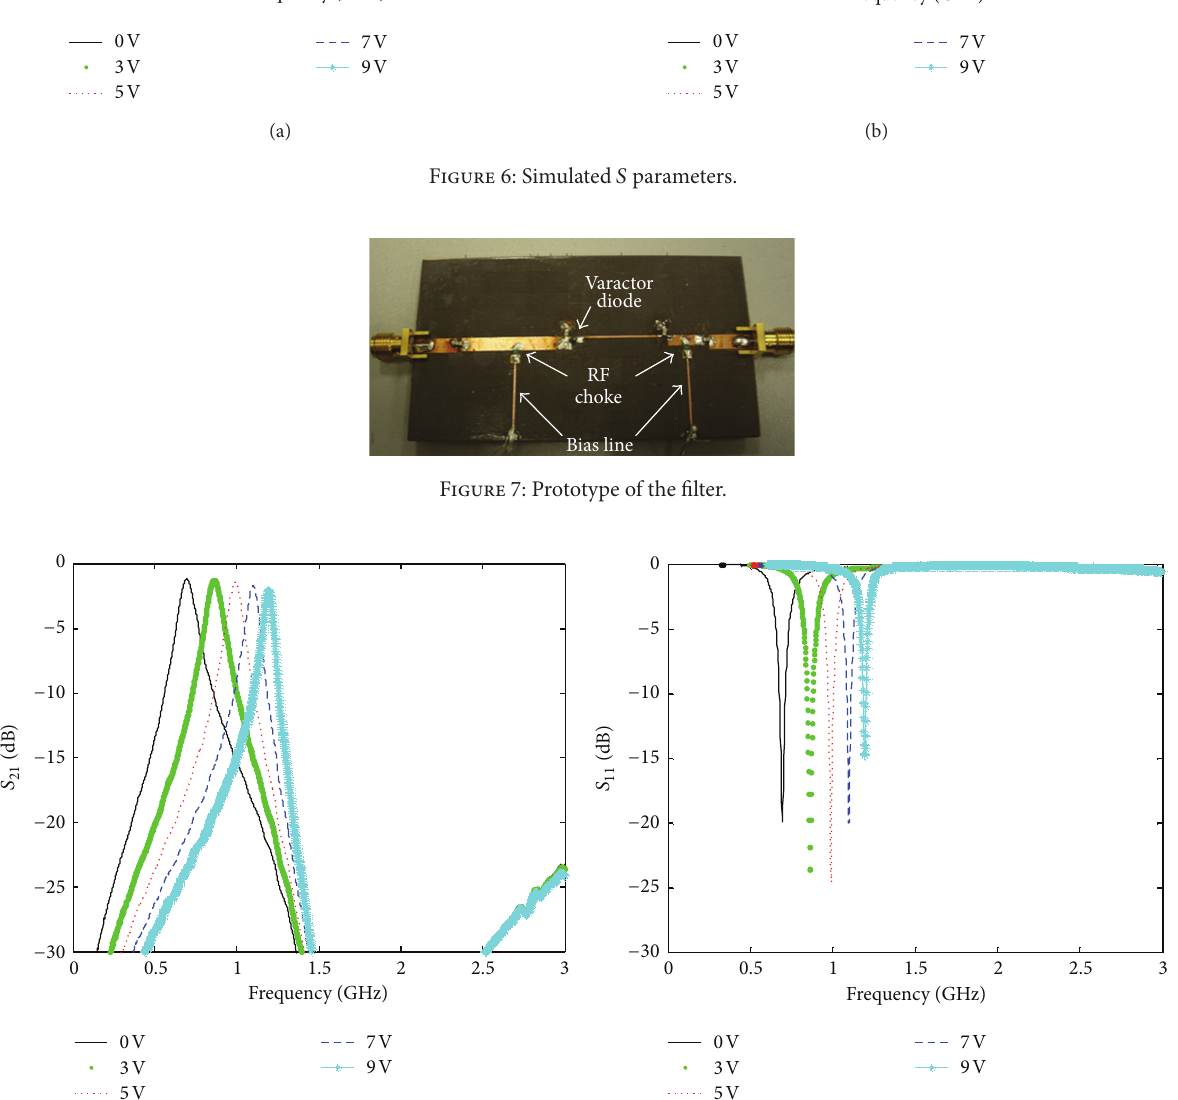
Figure 6: Simulated 𝑆 parameters.